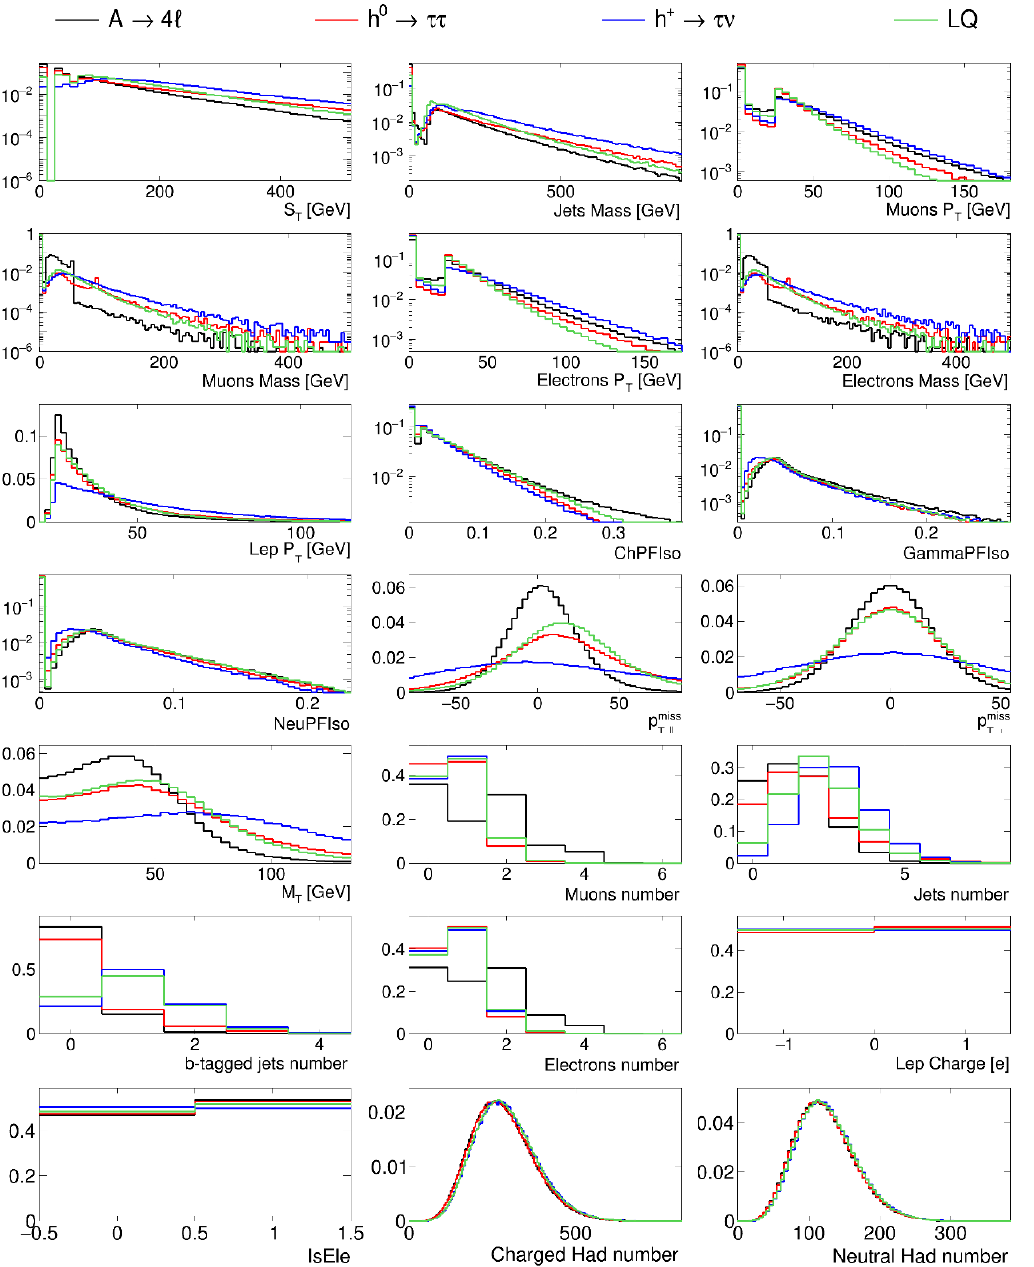
Figure 2 . Distribution of the HLF quantities for the four considered BSM benchmark models.